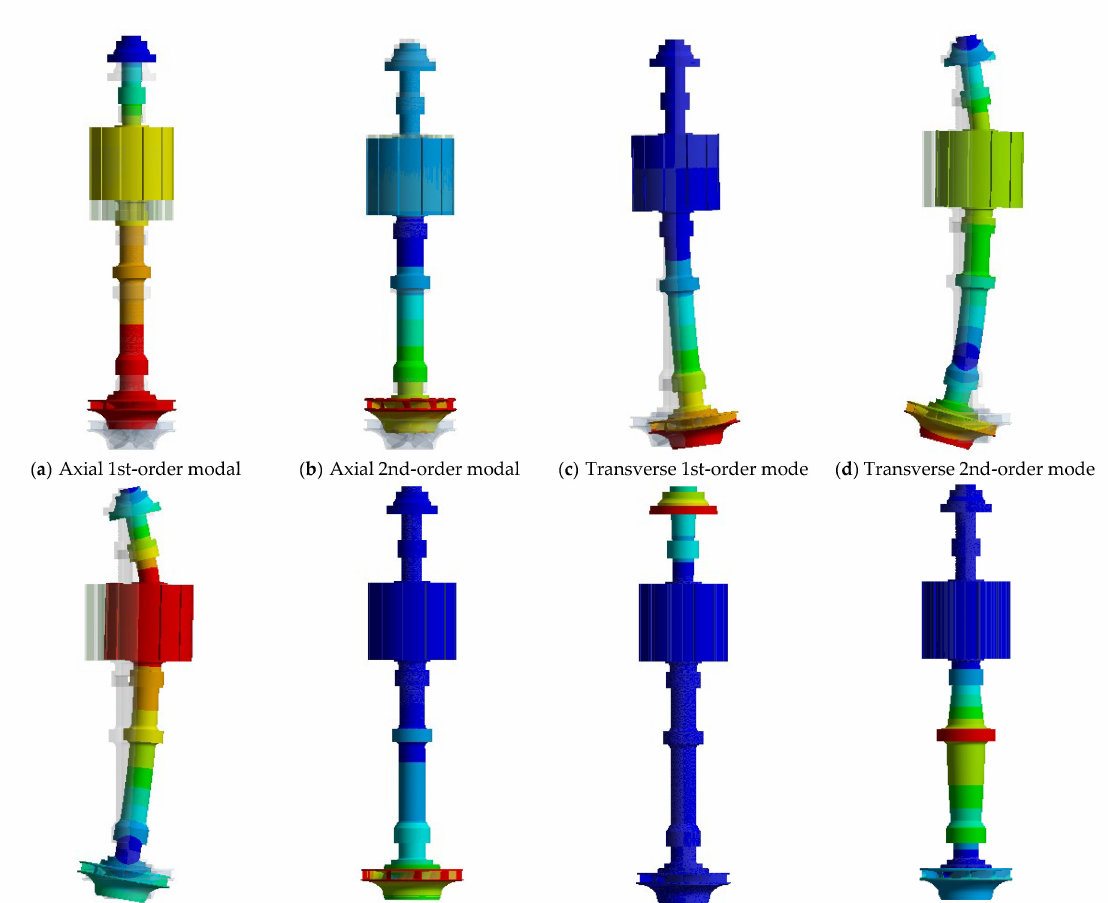
Figure 7. Low-order modal vibration pattern of the rotor